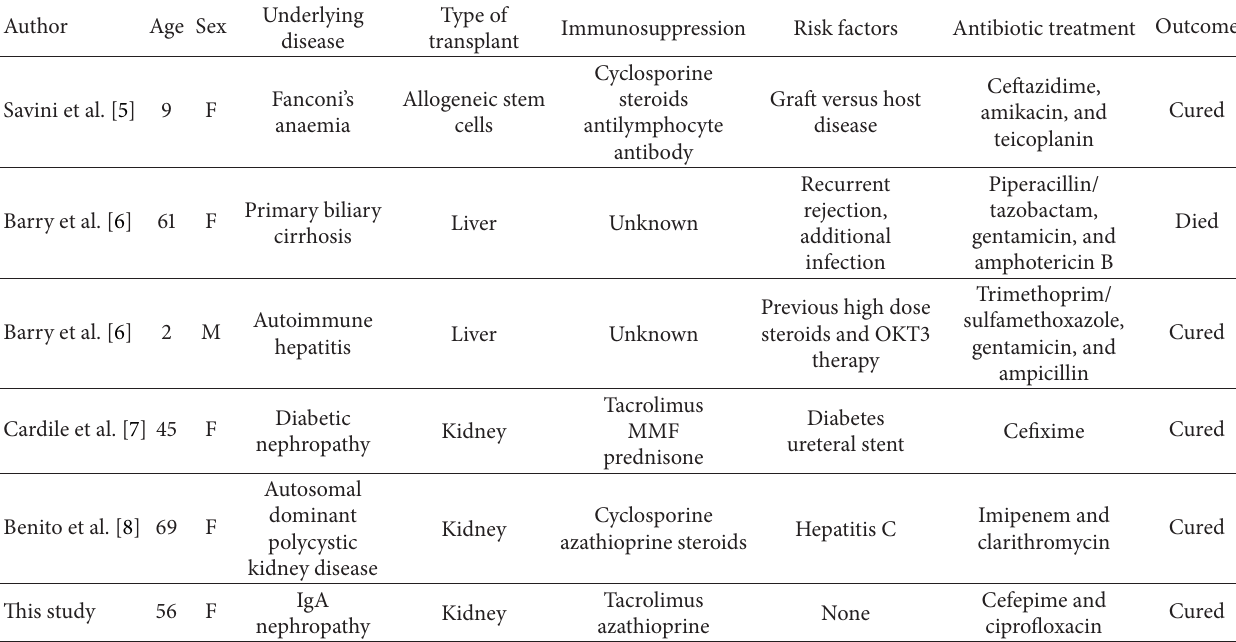
Table 2: H. alvei infections in transplant